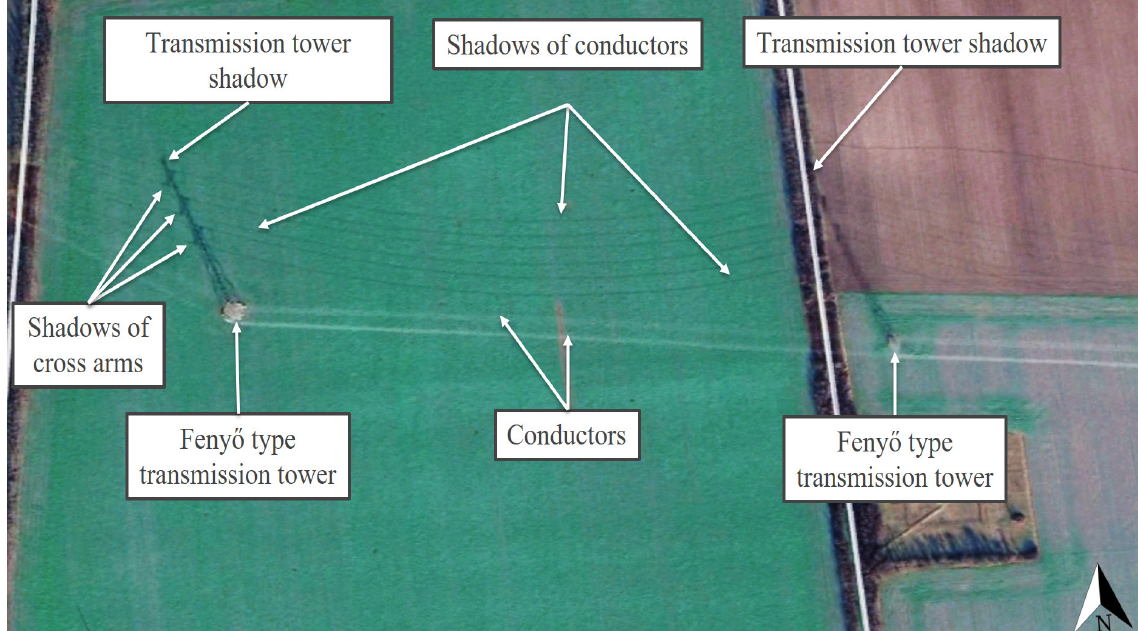
Figure 3. The shading effects of Fenyő-type transmission towers and their conductors on 2 January 2020 at approximately 11:30 a.m. (local time) in Táplánszentkereszt, based on [41].